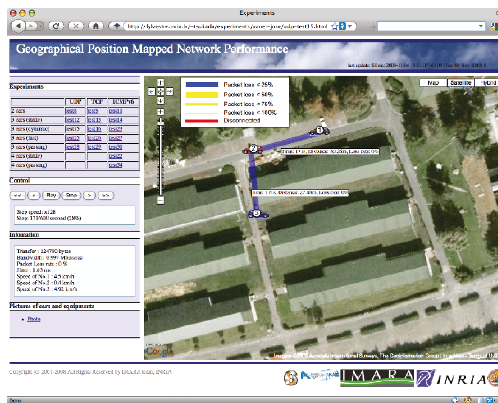
Figure 10: AnaVANET replaying a VANET experiment. Buildings avoid a direct line-of-sight communication, thus forcing the usage of multihop